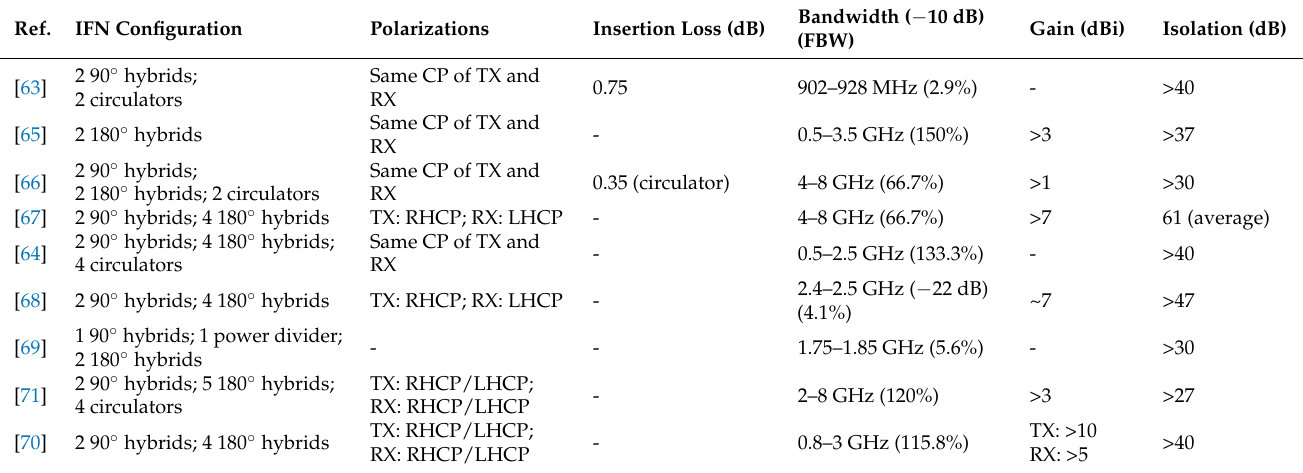
Table 3. A comparison of IBFD antennas with isolation feed network.